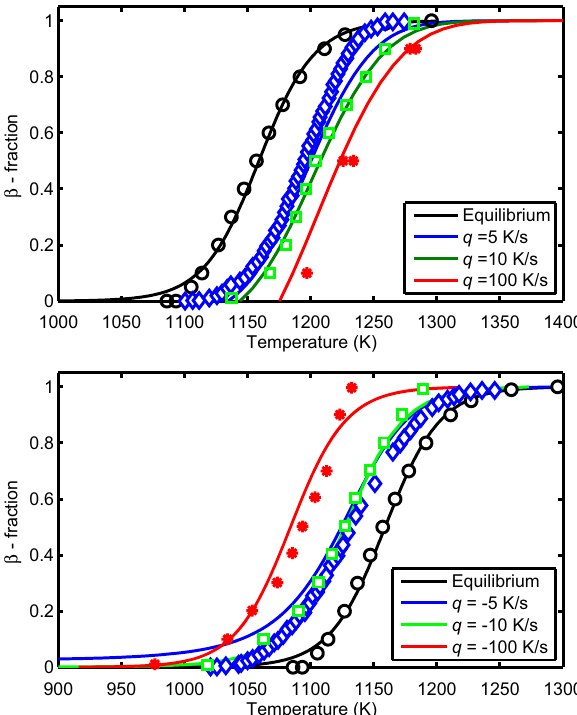
Figure 5. Volume fraction of β phase as a function of temperature calculated (lines) by using model A versus measured data (markers) 11, 21 for Zircaloy-4 at different heating/cooling rates (top/bottom) where q